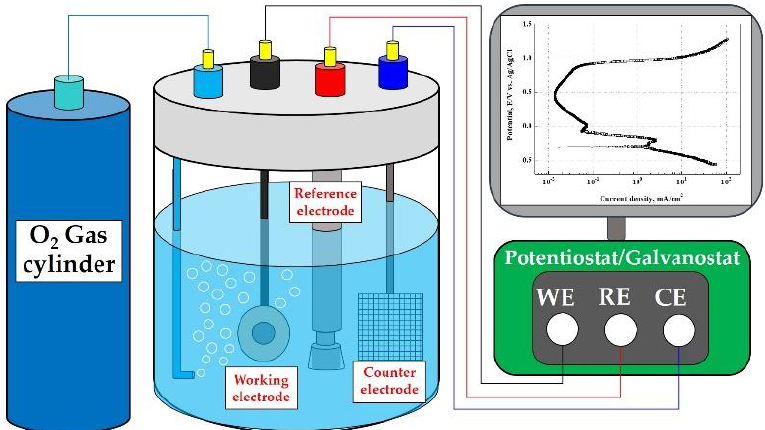
Figure 1. Schematic diagram of a three-electrode cell with O 2 gas bubbling and a potentio- stat/galvanostat for potentiodynamic polarization